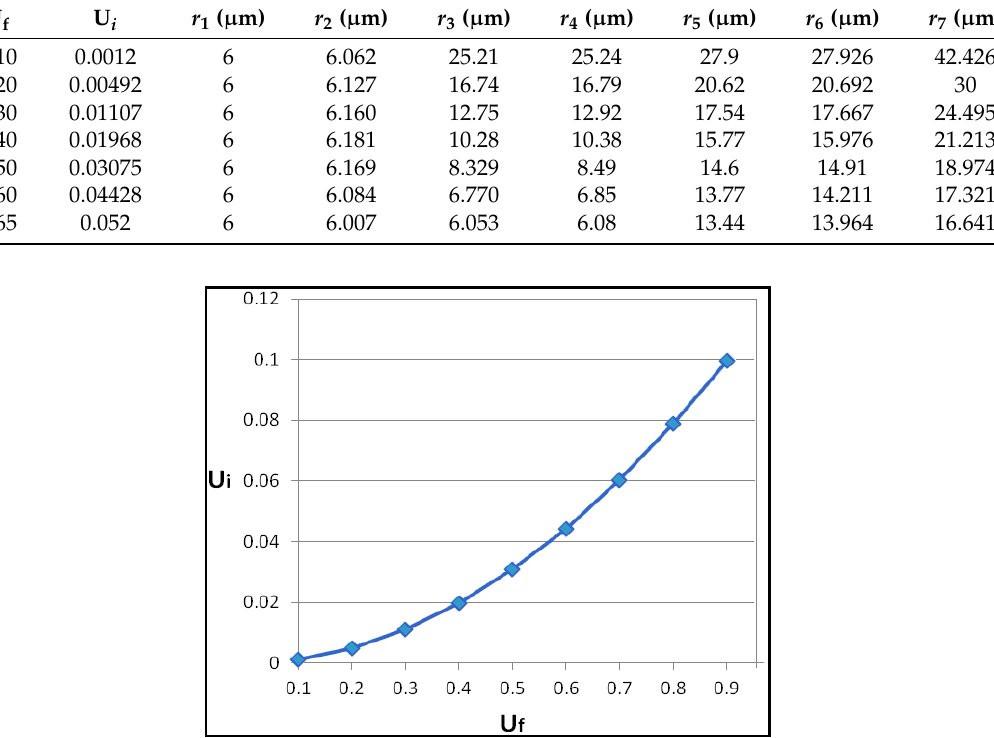
Table 2. Volume fractions of all phases. U 1